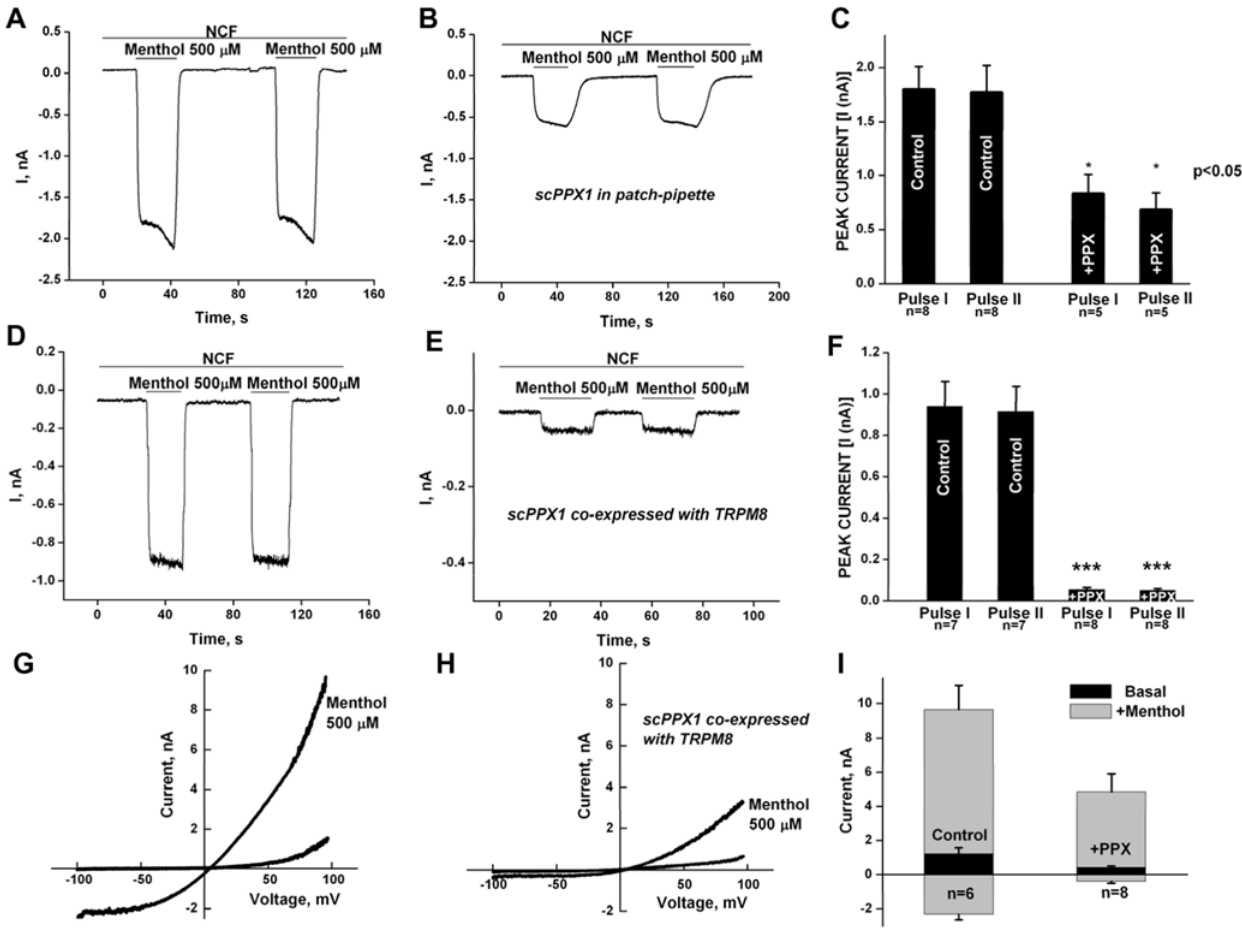
Figure 1. Inhibition of TRPM8 currents by scPPX1 in whole-cell patch clamp. Upper panels: Whole-cell patch clamp measurements of menthol-induced currents were performed at 2 60 mV in the whole-cell configuration on HEK cells expressing TRPM8, in nominally Ca 2 + -free solution (NCF), to avoid desensitization. Menthol pulses (500 m M) were applied in the first 3–5 min after establishment of whole-cell configuration: HEK-293 cells were transiently transfected with TRPM8 (0.4 m g) and co-transfected with GFP clone (0.2 m g) to allow detection of transfected cells. Panel A : the control. Panel B : the pipette solution was supplemented with 2.3 m g/ml scPPX1. Midle panels: Whole-cell patch clamp was performed on HEK-293 TRPM8 stable cell line, which was transiently transfected with GFP (0.2 m g) alone (panel D ) or with scPPX1 clone (0.4 m g) and GFP (0.2 m g) (panel E ). The summaries are shown in panel F . The protocol of experiment is the same as for the measurements in the upper panel. Lower panels: Current/ Voltage relationships of TRPM8 channels obtained in whole-cell patch clamp performed at 2 100 + 100 mV voltage ramps for HEK-293 TRPM8 stable cell line, which was transiently transfected with GFP (0.2 m g) alone (panel G ) or with scPPX1 clone (0.4 m g) and GFP (0.2 m g) (panel H ). The summaries are shown in panel I at 2 100 and + 100